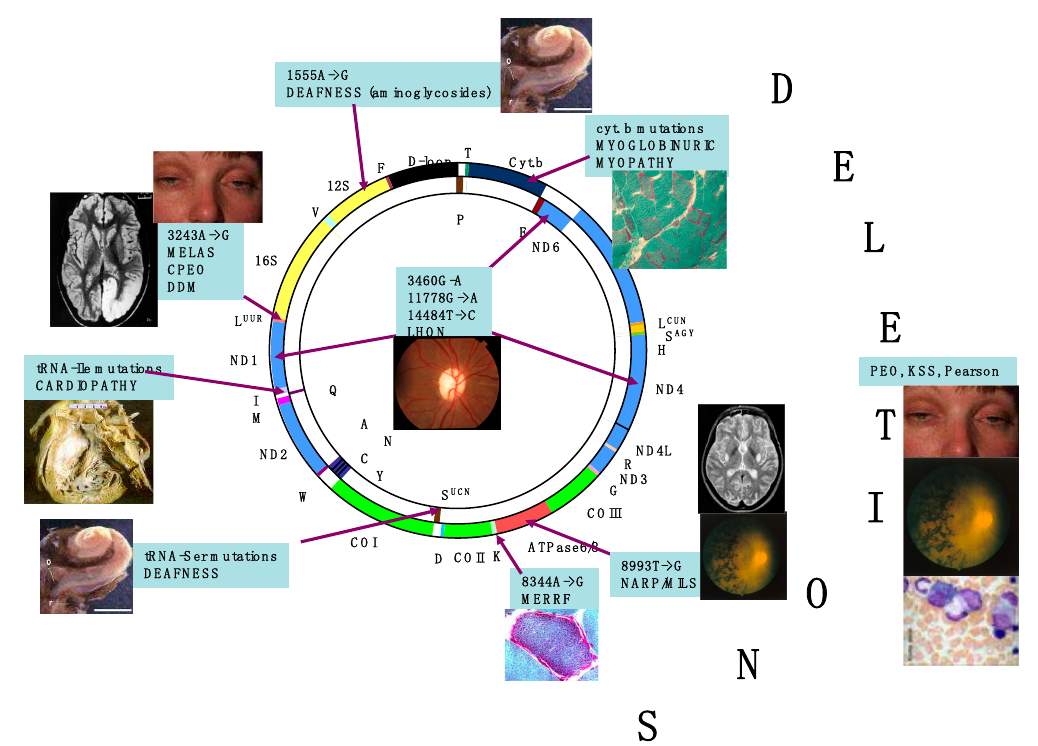
Figure 1. Morbidic map of mtDNA mutations. The scheme of the circular 16.5 kb human mtDNA is depicted, with several clinical and molecular syndromes associated with mutations of the molecule. Genes encoding subunits belonging to the same MRC complex have identical colours. In yellow are indicated the genes encoding the 12S and 18S ribosomal RNAs. Different colours and aminoacids expressed in the single-letter code designate the tRNA-encoding genes. The D-loop control region is in black. LHON is associated predominantly with three-point mutations, usually homoplasmic, in different genes of cI, but other, rare mutations have also been reported. Deletions, associated with KSS and other syndromes including adult-onset progressive external ophthalmoplegia and neonatal Pearson’ syndrome, usually affects the “major” arc occupying approximately two thirds of the mtDNA circle, included between the D-loop and the WANCY cluster where the origin of light strand replication is contained.